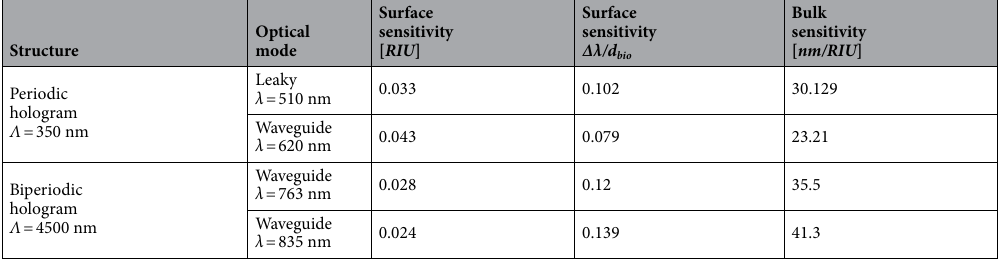
Table 1. Modal surface and bulk sensitivities of the